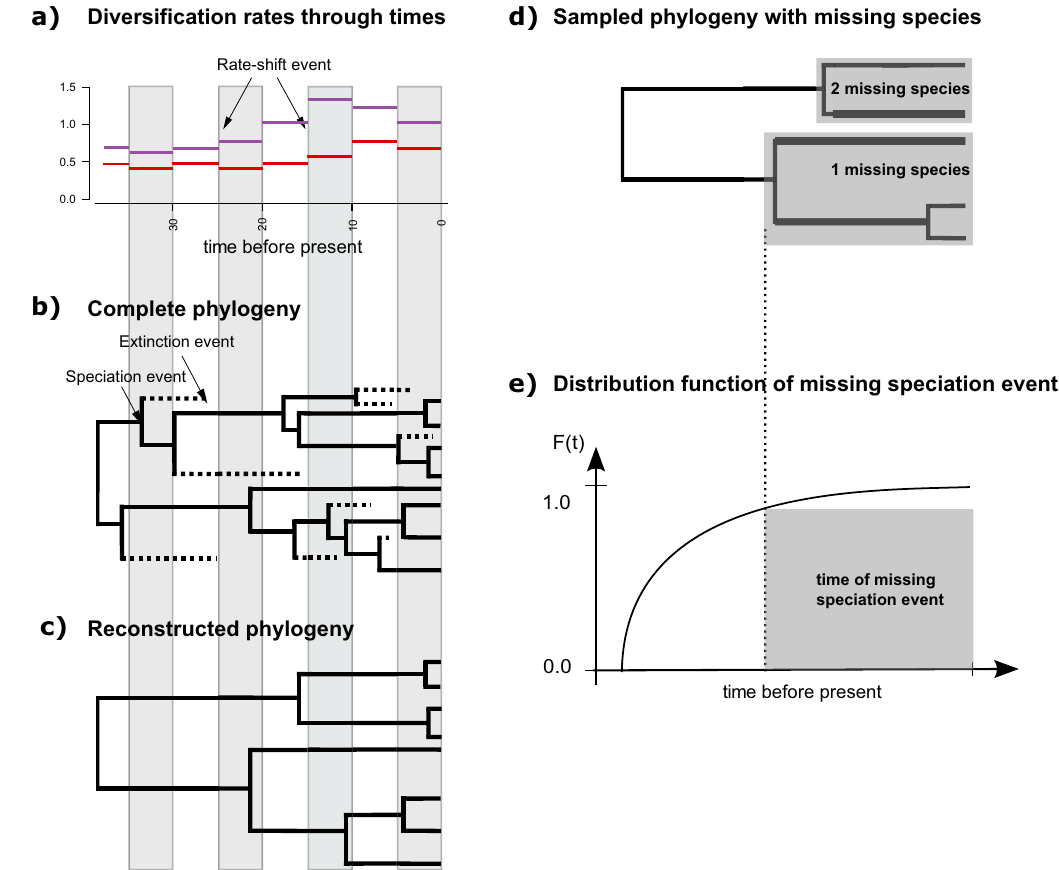
Fig. 4 Cartoon of the birth – death process with rate-shift events and empirical taxon sampling. a Depiction of the speciation (purple lines) and extinction (red lines) rates through time. Here we assume that speciation and extinction rates are episodically constant, that is, diversi fi cation rates shift instantly and only at the beginning of an episode. Each episode lasts fi ve time units in this example. b A realization (complete phylogeny) of the birth – death process. Lineages that have no extant or sampled descendant are shown as dashed lines and surviving lineages are shown as solid lines. c Reconstructed phylogeny corresponding exactly to the one shown in B with the extinct lineages pruned away. Thus, plot c depicts the “ observed ” phylogeny from which the speciation times are retrieved. d Sampled phylogeny with gray boxes depicting named clades with known number of missing species. The phylogeny is the same as in c with fewer taxa. e Distribution function of the time of the missing speciation event. The missing speciation event could have occurred any time between the crown age of the named clade and the present time (gray box). The distribution function is integrated over and hence the uncertainty of the missing speciation event accounted